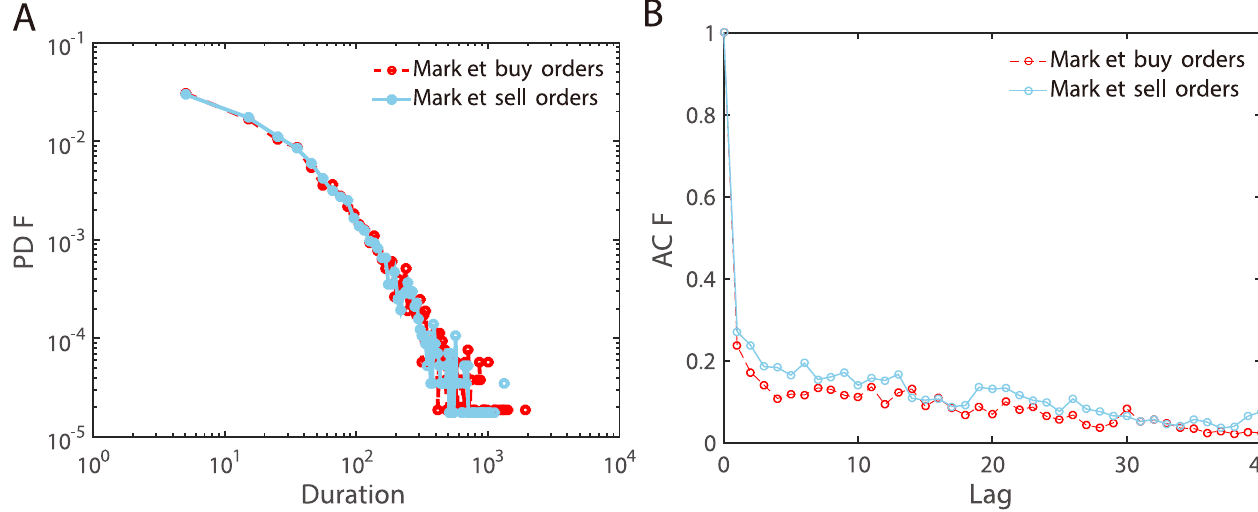
Fig 2. The duration distributions and correlations for aggressive market buy (sell) orders. A: The empirical distributions for the inter-arrival durations. B: The autocorrelation functions of inter-arrival durations. Time (the units on the X-axis) is shown in seconds.